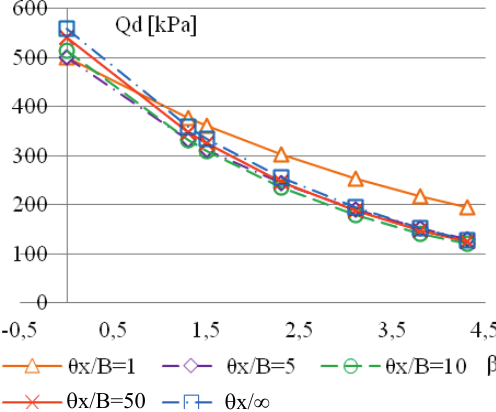
Fig. 10. Design values of the bearing capacity versus different β and